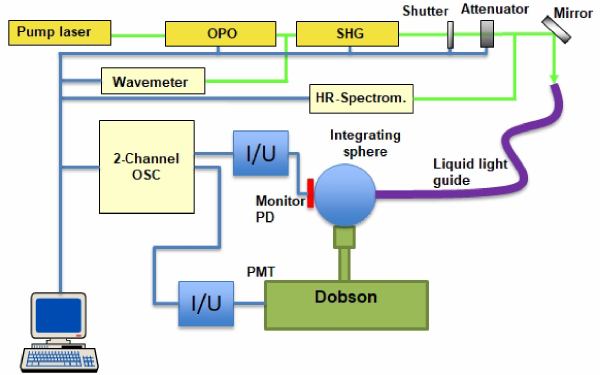
Figure 1. Schematic representation of spectral characterisations of Dobson spectrophotometers at the PLACOS setup of PTB. OPO: optical parametric oscillator; SHG: second harmonic generator; OSC: oscilloscope; I/U: current-to-voltage coverter; PD: silicon